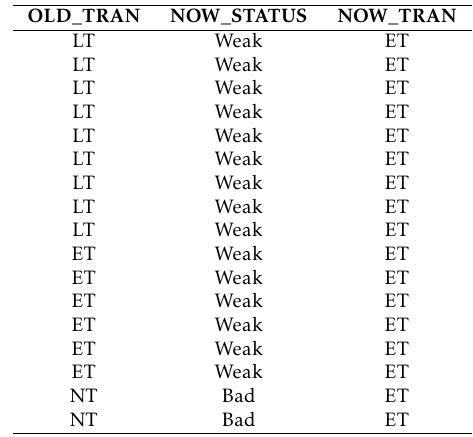
Table 2. Some experimental data (’NT’ = Normal Transmis- sion,’LT’ = Lineral Transmission, ’ET’ = Exporational Transmis- sion)